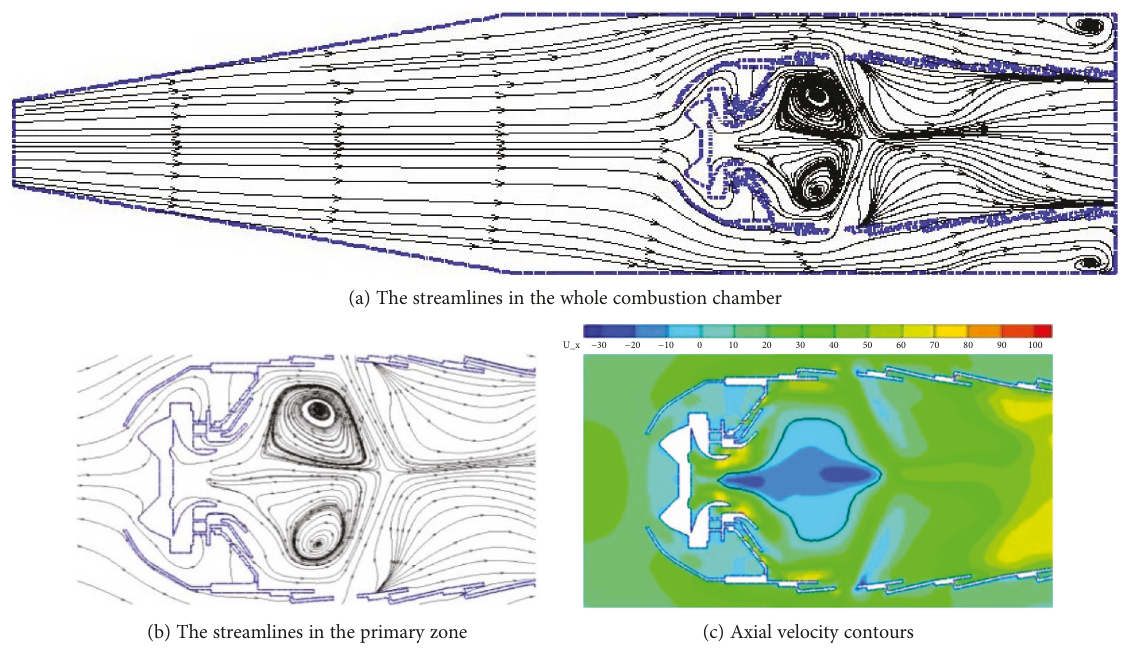
Figure 11: The streamlines and axial velocity contours at the center plane.